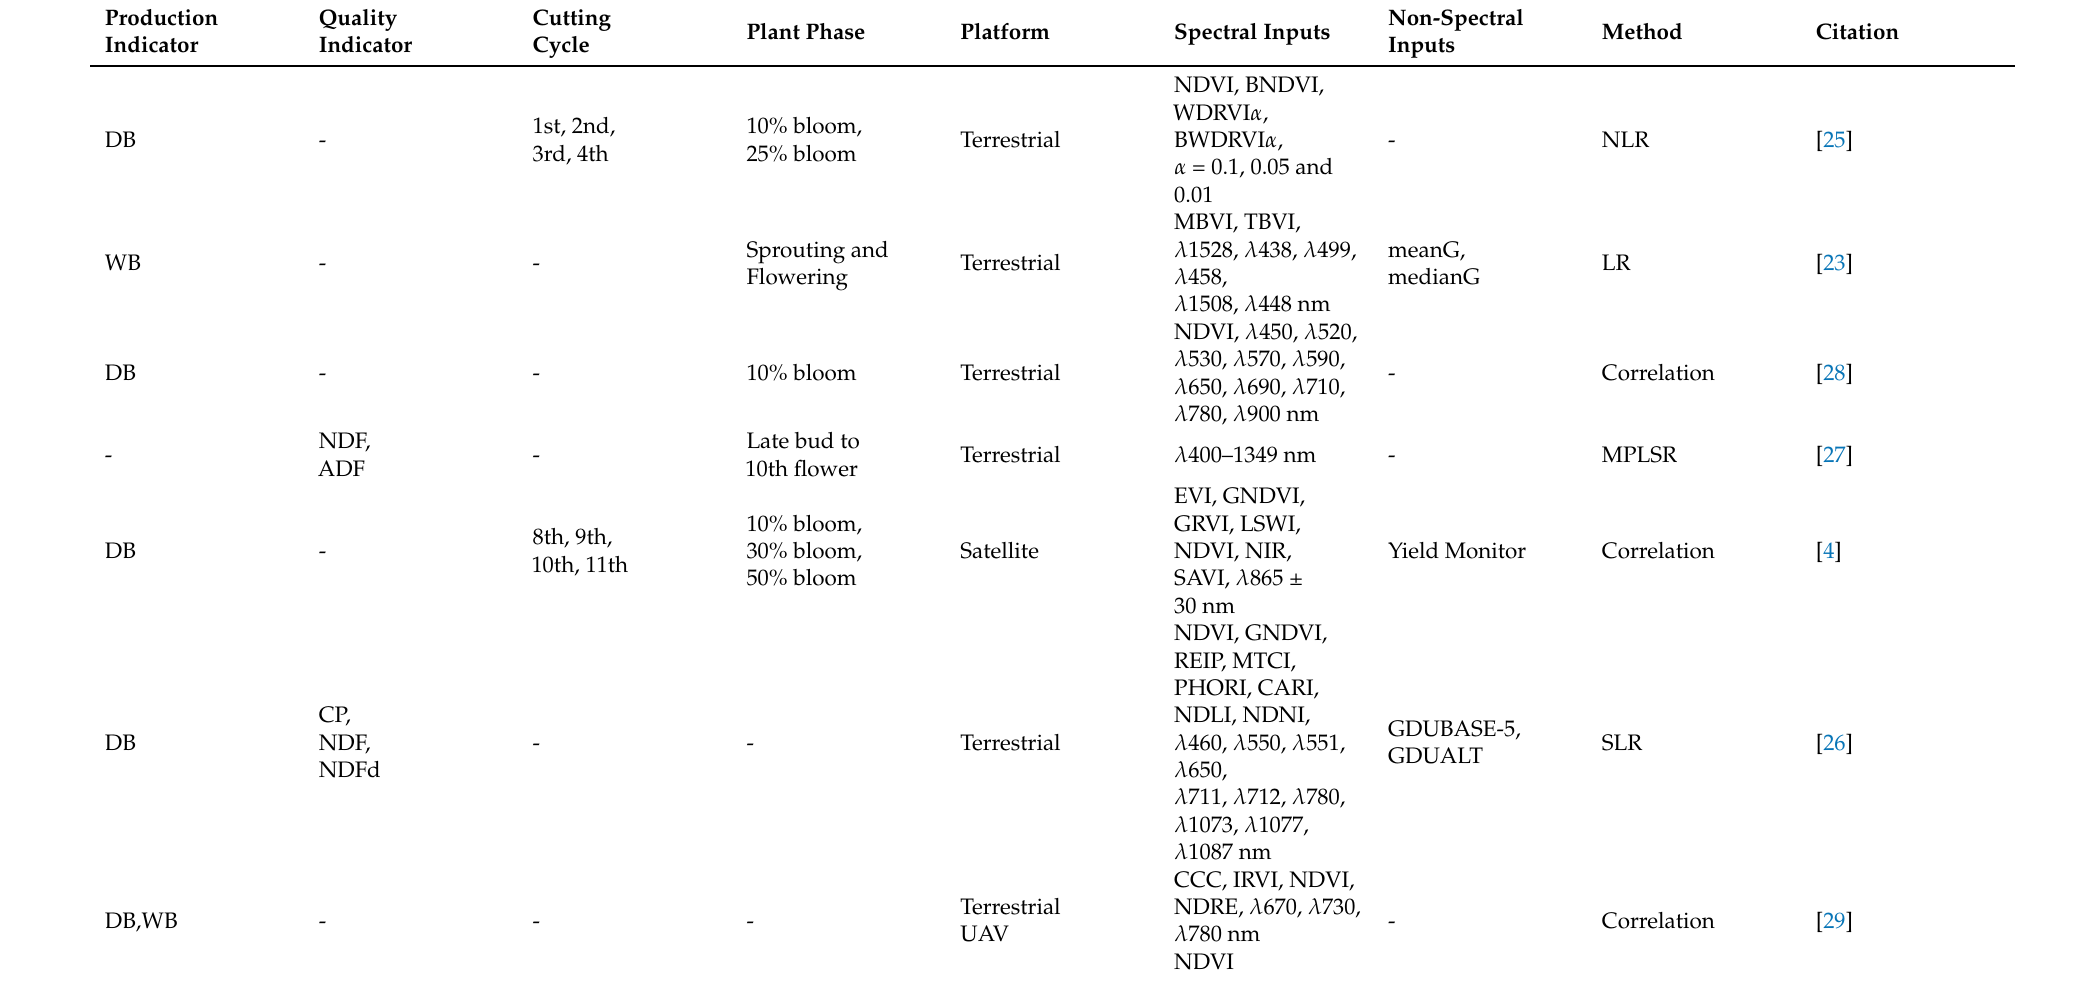
Table 2. Studies using data from remote sensing platforms for developing methods to assess alfalfa biomass and quality